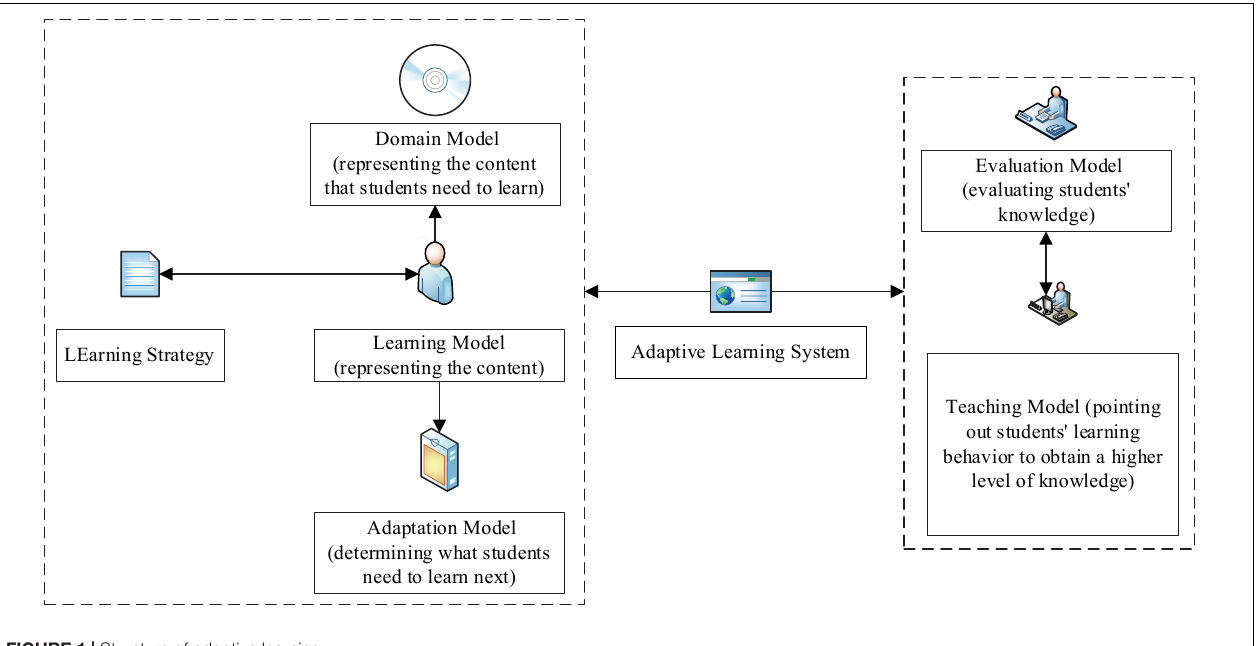
FIGURE 1 | Structure of adaptive learning.